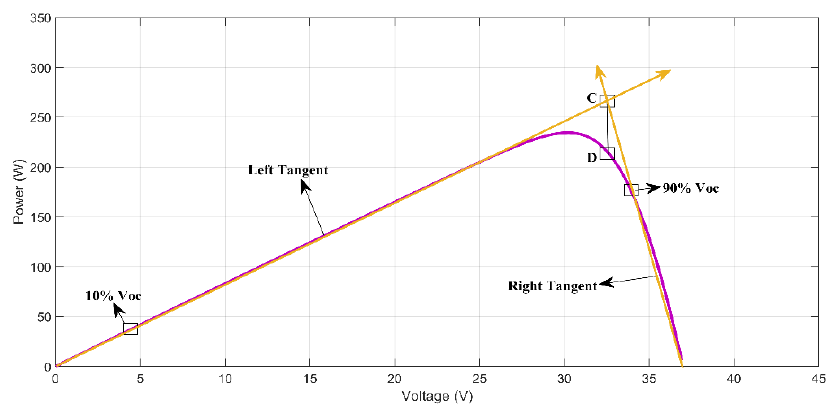
Figure 13. Tangent-based MPP estimation: C is Tangent intersection and D is PV MPP.